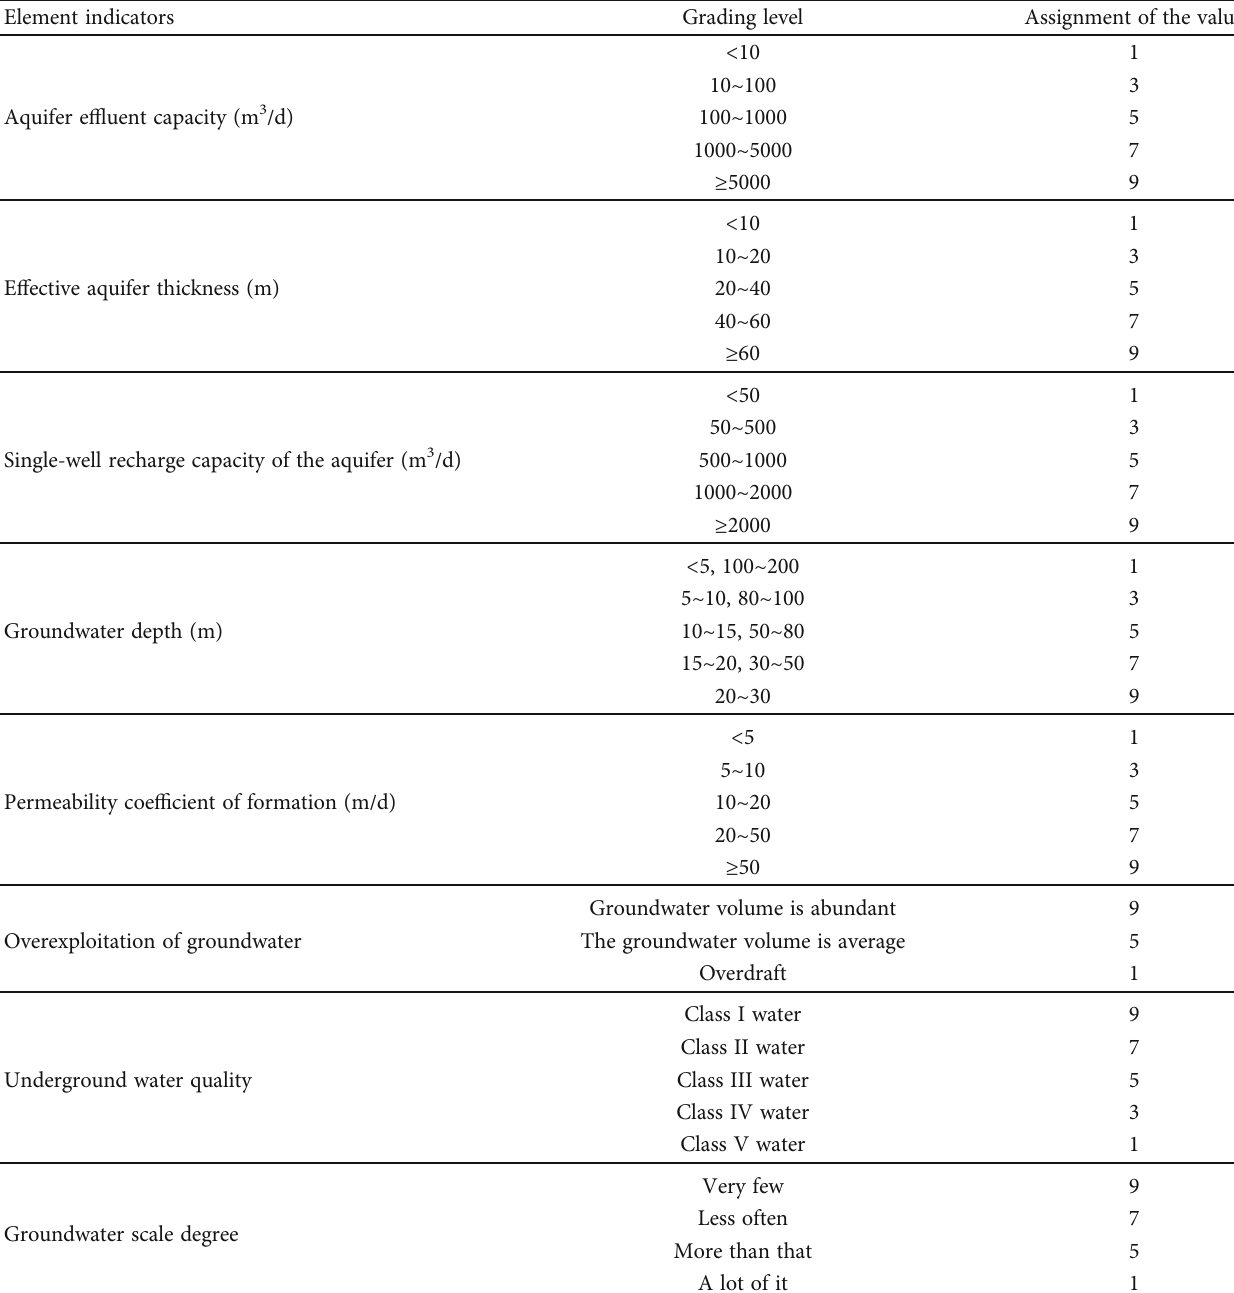
Table 4: Evaluation table of factors a ff ecting the suitability of the ground source heat